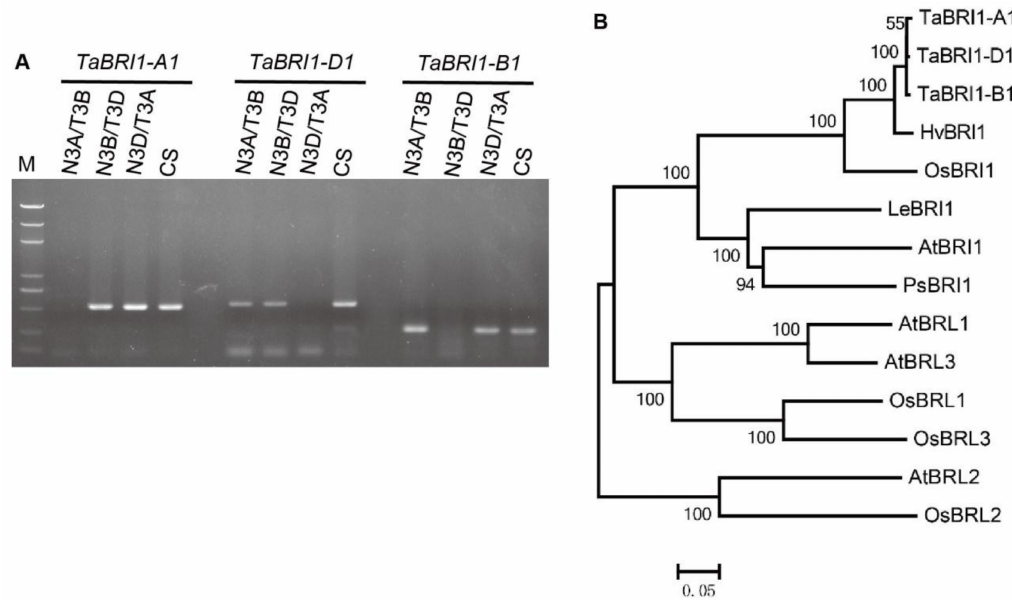
Figure 1. Chromosome location of TaBRI1 and phylogenetic analysis. ( A ) Chromosome location of TaBRI1 using nulli-tetrasomic and double ditelosomic lines derived from wheat cultivar Chinese Spring (CS). M, DL2000 DNA marker; N3A / T3B, N3B / T3D, N3D / T3A, three nulli-tetrasomic